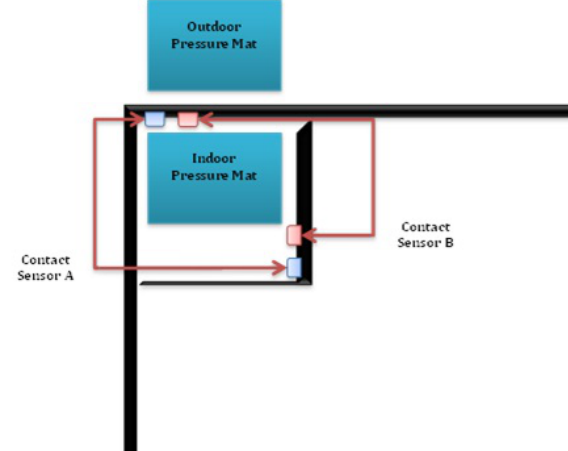
Figure 1: Static sensor topology.